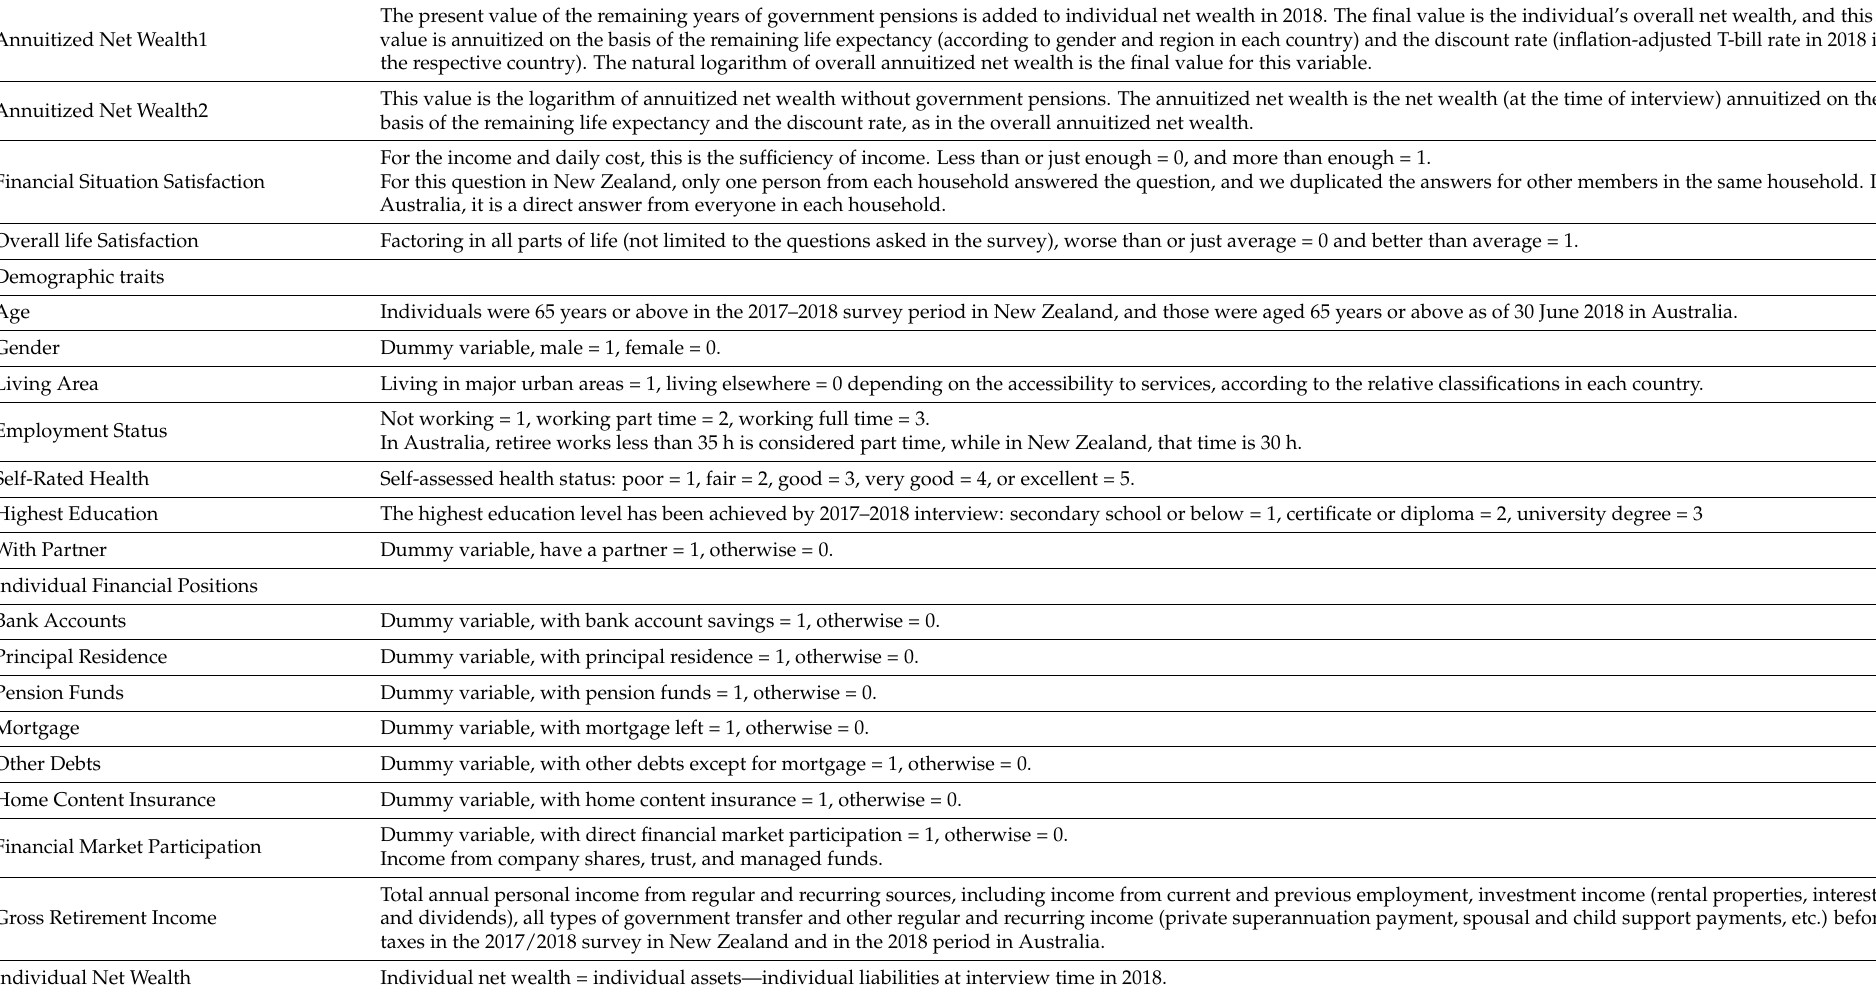
Table A2. Variable